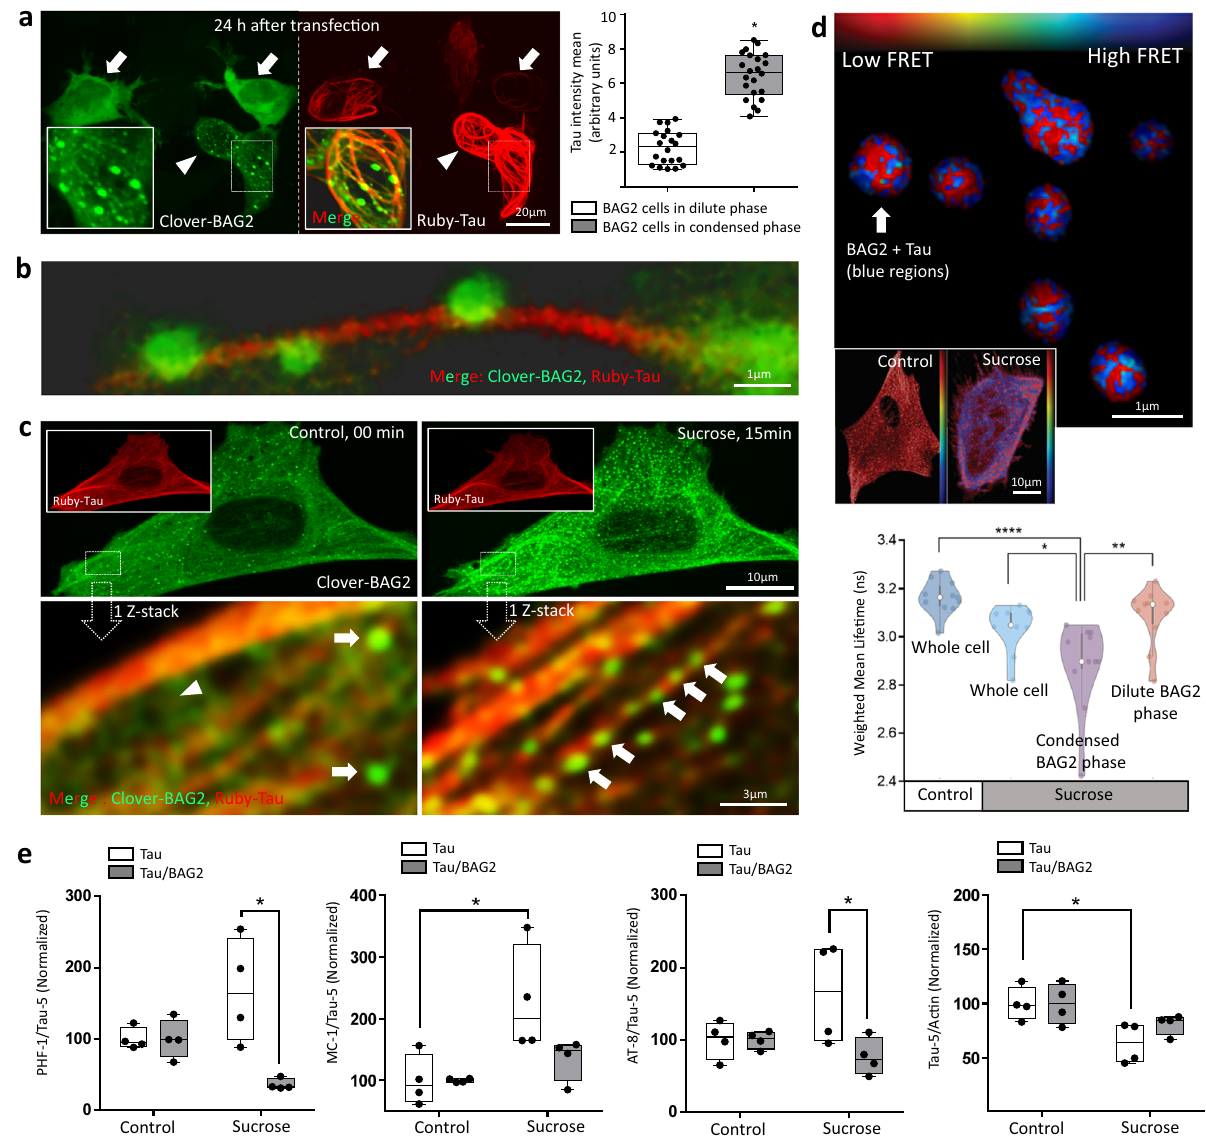
Fig. 6 Function of BAG2 condensates. a SH-SY5Y cells transiently expressing ruby-Tau and clover-BAG2 after 24 h show BAG2 in dilute phase (arrow) and dense phase (arrowhead). Fluorescence of Tau intensity was normalized by its highest value in these two populations ( n = 3, 20 cells for dilute and 22 for dense phase, * p = 2.4 × 10 − 14 , two-sided Student ’ s t test). Box: 25th and 75th percentiles. Line: median. Whiskers: smallest to the largest values. Dots: represent individual cell. b BAG2 condensates aligned along microtubules (Supplementary Movie 4). c SH-SY5Y stably expressing clover-BAG2 and ruby- Tau after stress (sucrose, 15 min) increase BAG2 condensates and their alignment along the microtubules (arrows). Arrowhead: BAG2 dilute phase. d BAG2-Tau interaction by FLIM-FRET. Image displays the fl uorescence lifetime (red: 3.2 ns - no energy transfer; blue: lower lifetime - energy transfer). Graphical representation of the lifetime signal before and after stress in the whole cell, condensates or dilute phase. Over the entire cell, lifetimes did not change signi fi cantly after stress. However, the lifetime images indicated a signi fi cant FRET signal within condensates after stress (top). By segmenting the images and fi tting pixels belonging to distinct condensates, the fi t had an average weighted mean lifetime of 2.8 ± 0.1 ns, signi fi cantly lower compared to control (**** p = 2.7 × 10 − 5 ) or to whole cells after stress (* p = 2.8 × 10 − 2 ). When measuring only the dilute BAG2 phase in stressed cells (excluding condensates) the average weighted mean lifetime was 3.1 ± 0.1 ns which also differed from the condensates (** p = 2.6 × 10 − 3 ). Therefore, the majority of BAG2-Tau interactions occur in condensates. 11 cells, n = 3; One-way ANOVA followed by the Tukey`s test. Floating lines: 25th and 75th percentiles. Circle: median. Violin: smallest to the largest values. Dots: individual cell. e Cells stably expressing Tau or Tau-P2A-BAG2 were subjected to stress (sucrose 500 mM, 2 h) and resolved with Tau-5, PHF-1, MC-1, and AT-8. n = 4 (see Supplementary Information). Under stress, the presence of BAG2 decreased the ratio of PHF (* p = 2.6 × 10 − 3 ), MC-1 (* p = 1.7 × 10 − 2 ) and AT-8 (* p = 4.0 × 10 − 2 ) to total Tau. two-way ANOVA followed by the Tukey`s test. Box and whiskers: same as in “ a ” . Dots represent